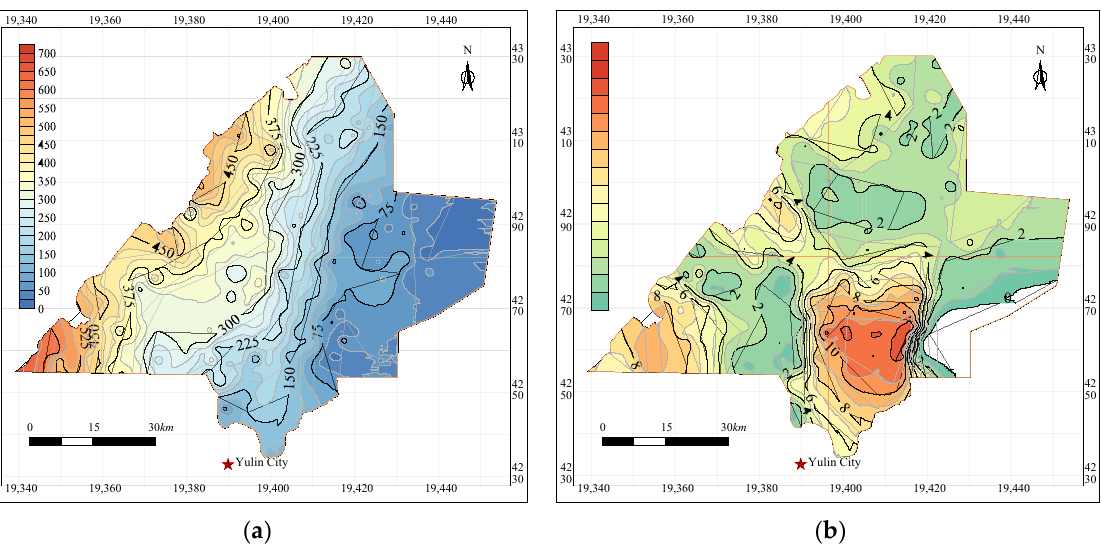
Figure 12. Thematic maps of the coal seam system. ( a ) contour map of the buried depth of the first-mined coal seam; ( b ) contour map of the thickness of the first-mined coal seam.